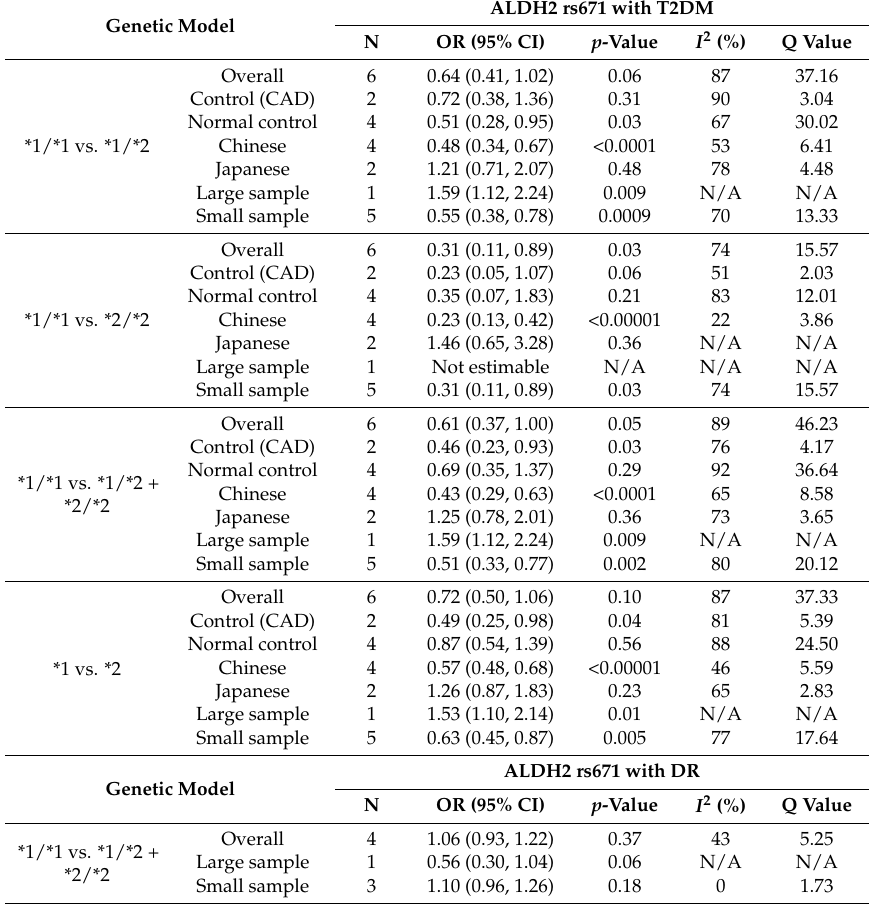
Table 3. Pooled odds ratios (ORs) and 95% confidence intervals (CIs) of the association between ALDH2 rs671, T2DM, and DR. ALDH2 rs671 with Genetic Model